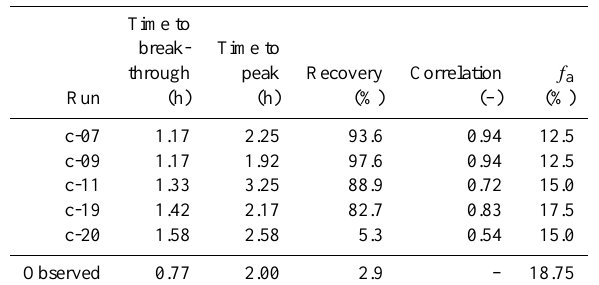
Table 5. Summary of solute transport characteristics of success- ful simulations and observation: Times to breakthrough and peak, recovery of tracer, correlation of observed and simulated break- through curves (Pearson’s r) , and the scaling factor f a (percentage of preferential flow paths across the slope width) that produced the maximum correlation in the solute transport simulations. The ob- served percentage of preferential flow paths is a mean value found with a plot-scale dye-staining experiment (Wienhöfer et al., 2009a) for depths greater 0.05m.